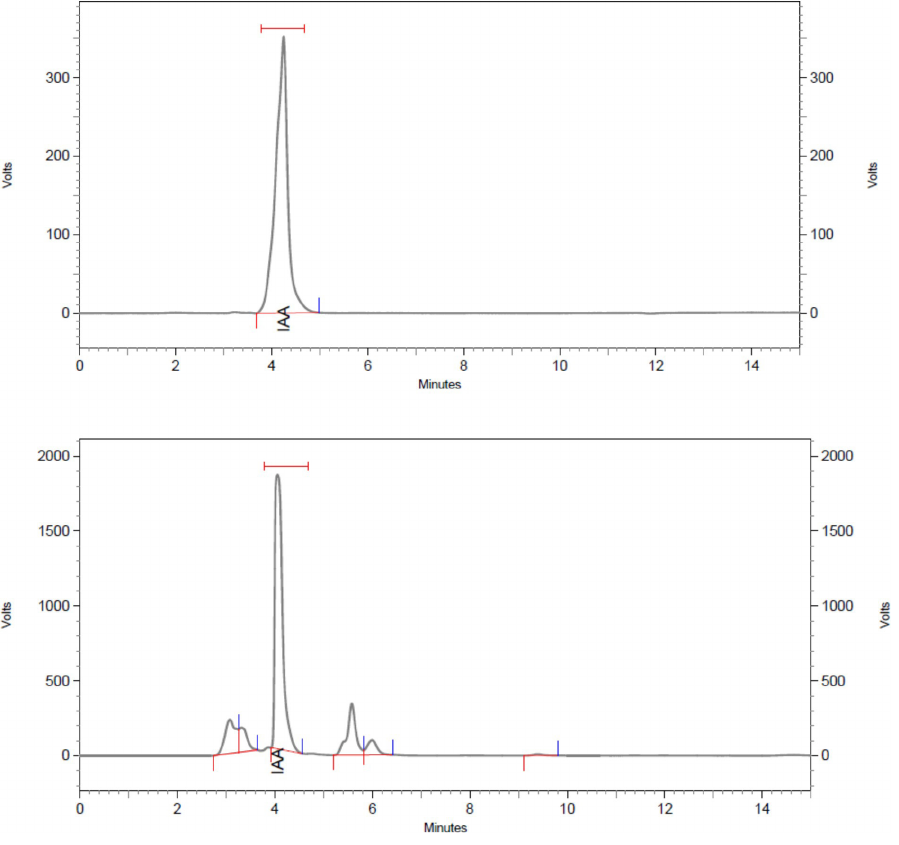
Fig. 1. HPLC analysis of Indole Acetic